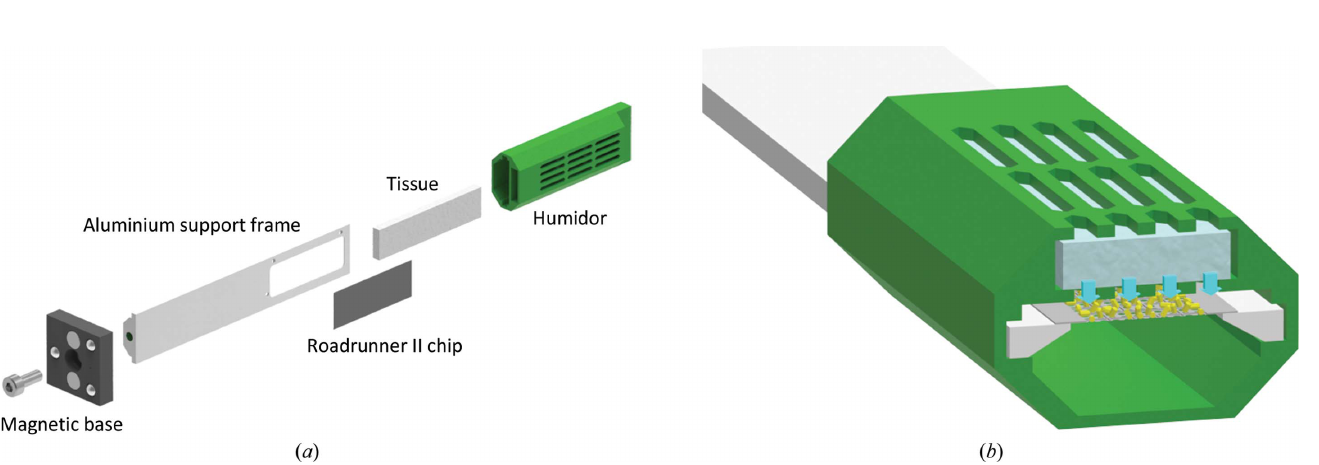
Figure 3 Roadrunner II chip design. ( a ) For assembly, a magnetic base (Thorlabs) is screwed to an aluminium support frame and a Roadrunner II chip is glued on top of the frame cavity. Both assembly steps are assisted by special tools to guarantee perpendicular installation of the base with respect to the support frame and a defined and reproducible position of the chip. The humidor (green) is equipped with a dry piece of tissue and can be slid to the base of the aluminium support frame. ( b ) The humidor was designed to keep naked crystals on the chip in a humid environment. For the short transport between the crystal-preparation laboratory and the beamline, the tissue in the humidor is soaked with water or mother liquor through the gaps on top and the humidor is slid over the